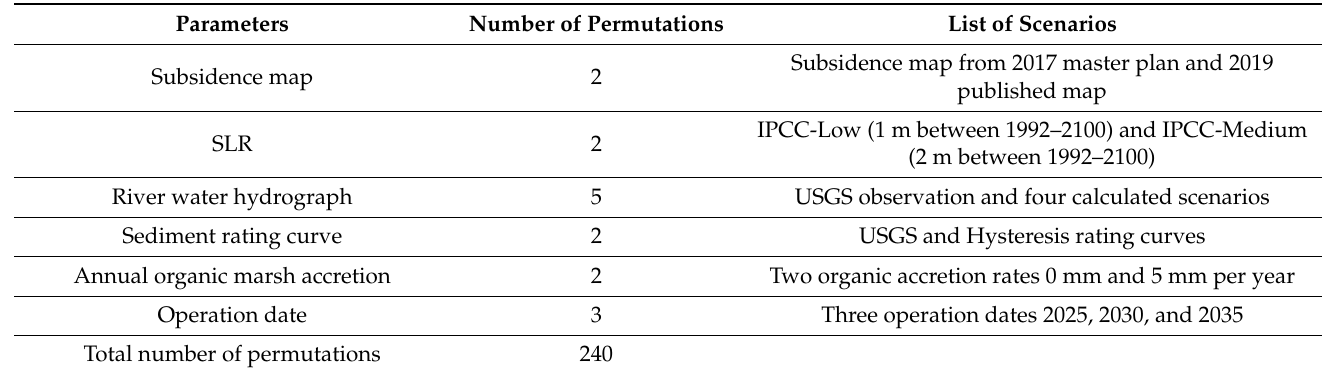
Table 1. Permutations of the morphodynamic numerical experiments. Note: In addition to the 240 permutations, 16 future-without-action simulations are performed to allow for calculating net land change due to the implementation of the sediment diversion.